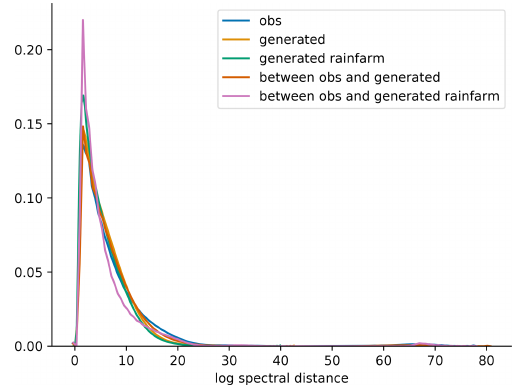
Figure 8. Distribution of hourly logarithmic spectral distances ( d ) for the observed patterns (blue), patterns generated with the GAN (yellow), patterns generated with RainFARM (green), and distances between patterns observed and generated with GAN (red) and be- tween patterns observed and generated with RainFARM (purple), for 500d (resulting in 12000h) from the test set.